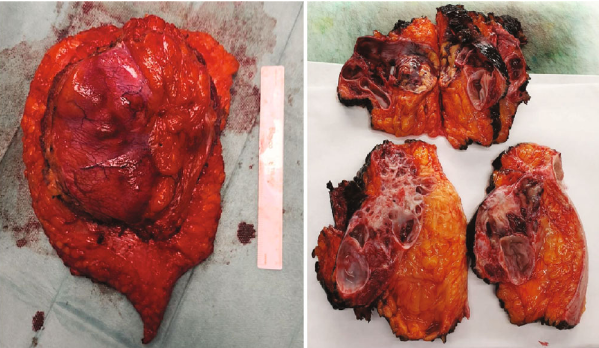
Figure 4: Well-de fi ned mass with septa inside, which is of interest to the skin, fatty tissue, muscle, and the posterior sheath of the anterior rectus abdominis without a ff ecting the peritoneum or abdominal